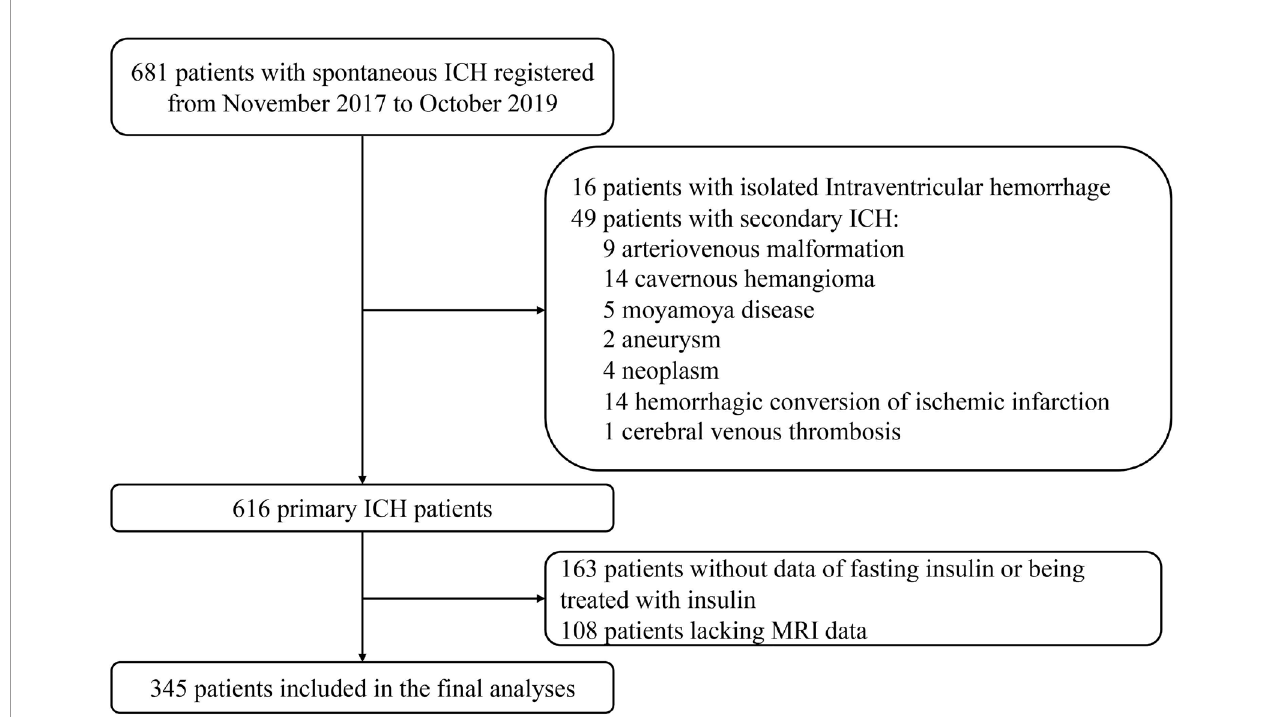
FIGURE 1 | Flow chart of patient enrollment. ICH indicates intracerebral hemorrhage; MRI, magnetic resonance